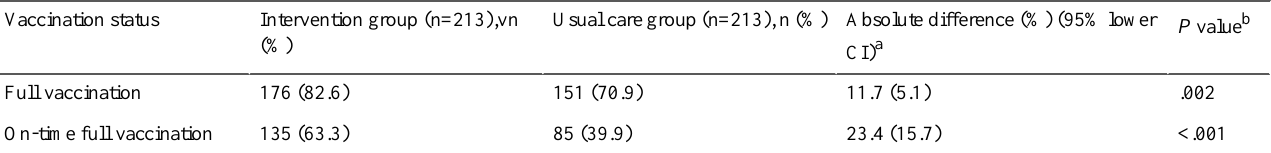
Table 2. Effect of mobile phone text message reminders on full and timely completion of vaccination among infants in Gondar city, northwest Ethiopia in 2020 (N=426).